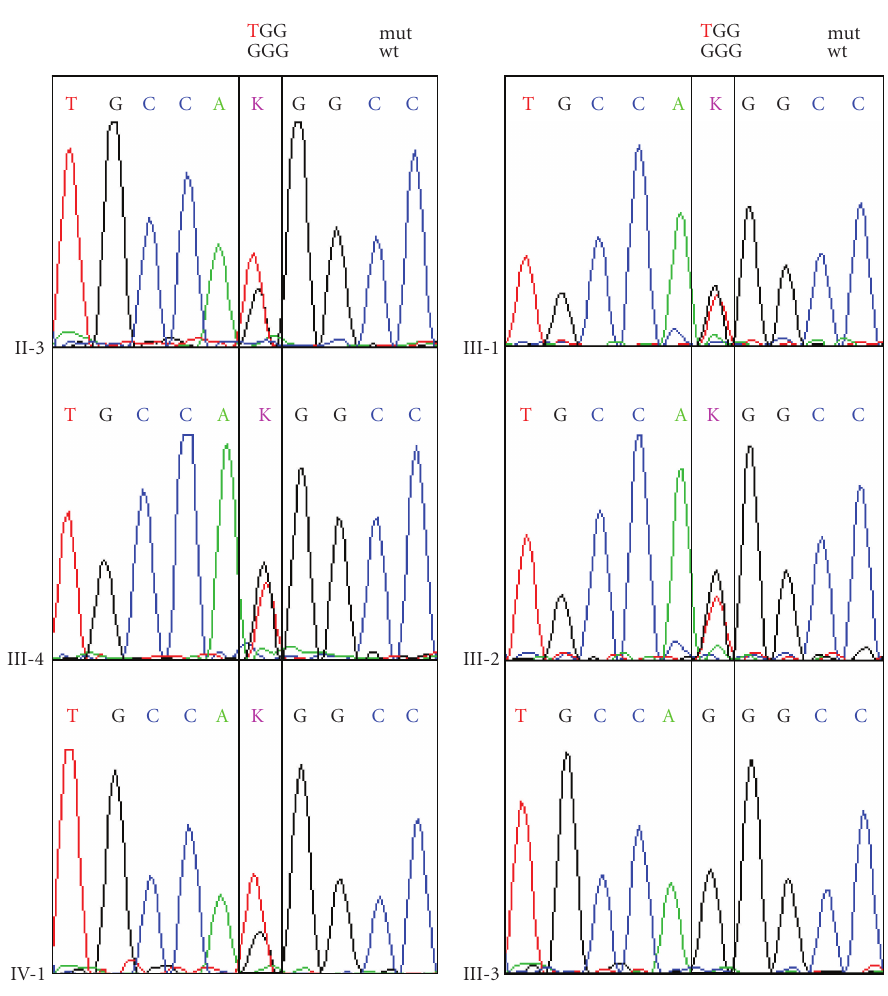
Figure 5: Detection of SNP 7006G > A; G2336W in COL7A1 by sequence analysis in selected family members, except sample III-3, which is wildtype for this locus.